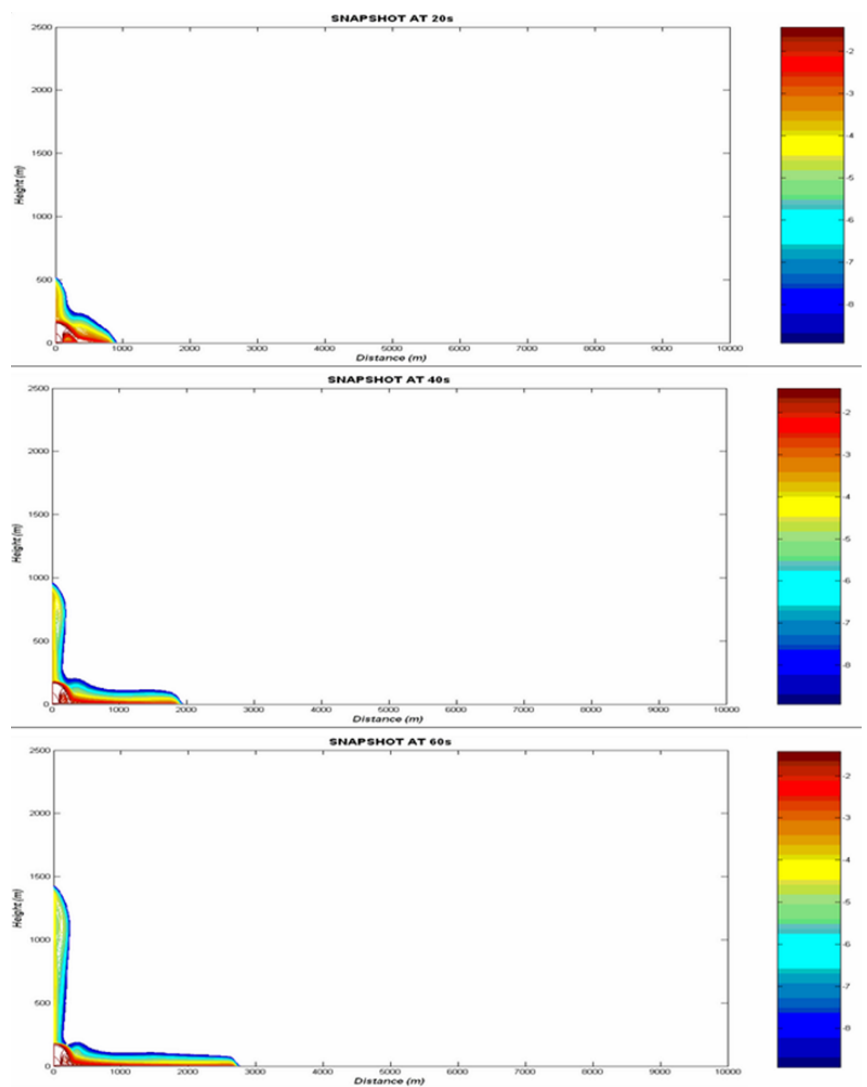
Fig. 2a. Snapshots of the solid particle concentration (logarithmic scale) as a function of distance and height at 20s, 40s, and